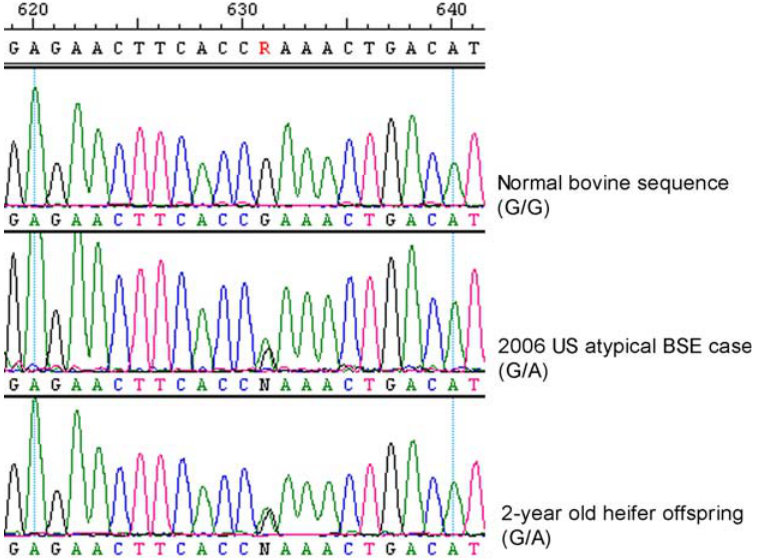
Figure 1. Sequencing output for bovine reference sequence, 2006 US atypical BSE case, and 2-year-old heifer offspring. The bovine reference sequence is homozygous for G at nucleotide 631. The 2006 US atypical BSE case and the 2-year-old heifer offspring are heterozygous G/A at nucleotide 631.